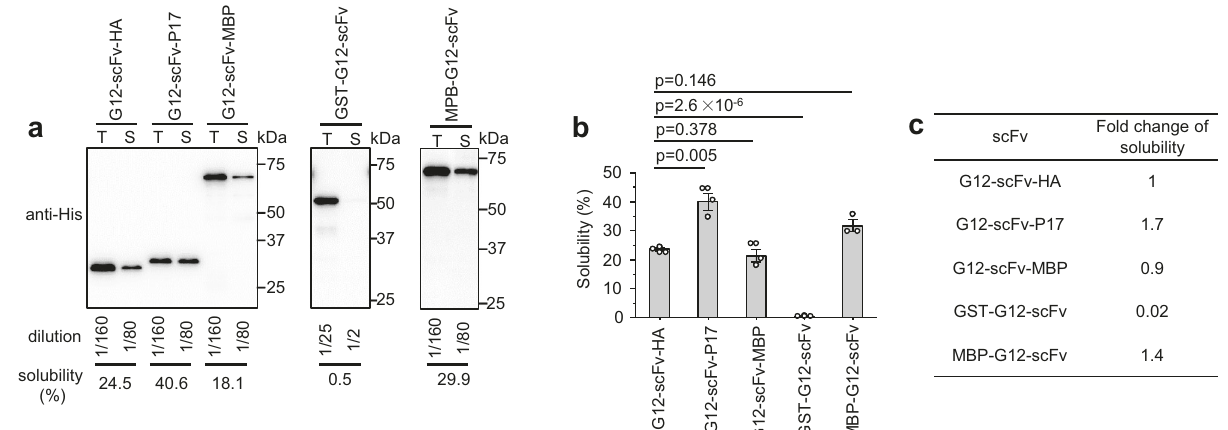
determined by three independent experiments. c Fold change of solubility of P17, MBP, and GST-tagged scFvs compared to HA-tagged scFv. Data are presented as mean values±SD. The statistical signi fi cance of differences between the two experimental groups was assessed by one-way ANOVA.